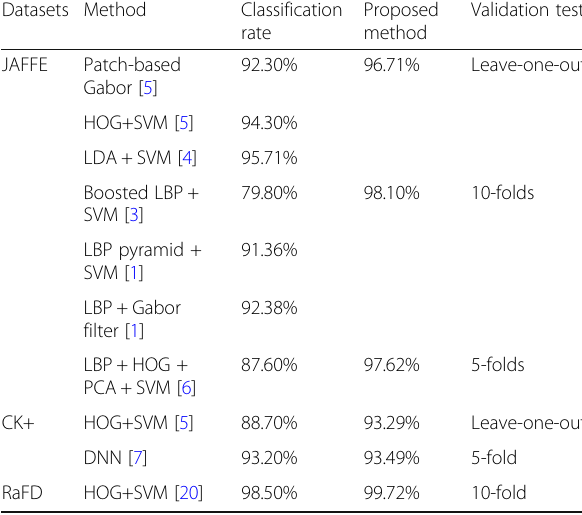
Table 5 Proposed accuracy method compared with